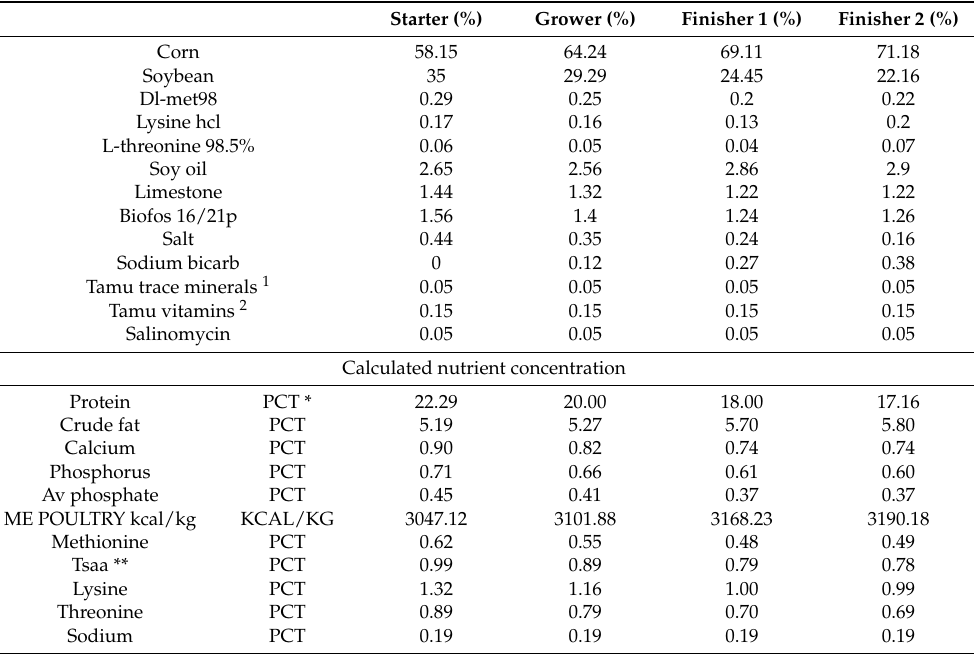
Table 1. Diet formulations fed to broilers in Experiments 1 and 2. Starter (%) Grower